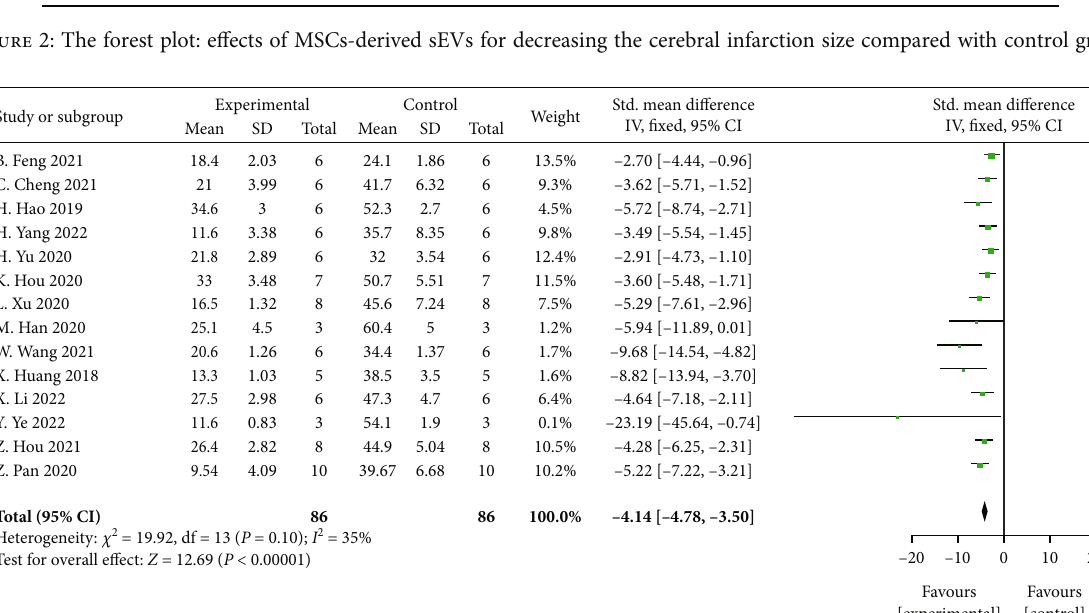
Figure 3: The forest plot: e ff ects of MSCs-derived sEVs for decreasing apoptosis rate compared with control